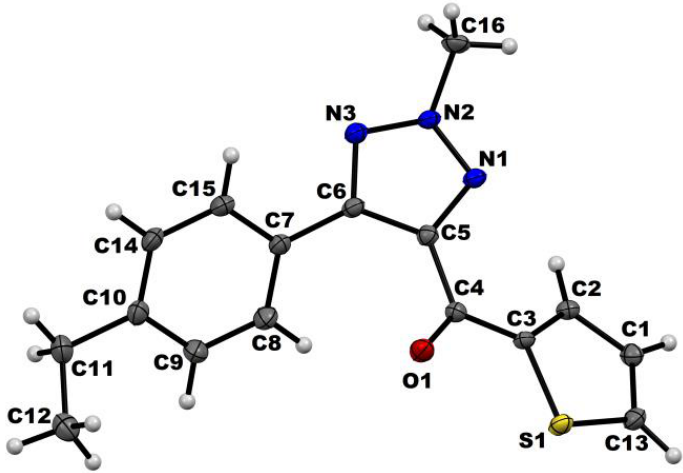
Figure 2. The Oak Ridge Thermal Ellipsoid Plot (ORTEP) of GKV10 drawn with 50% ellipsoidal probability.